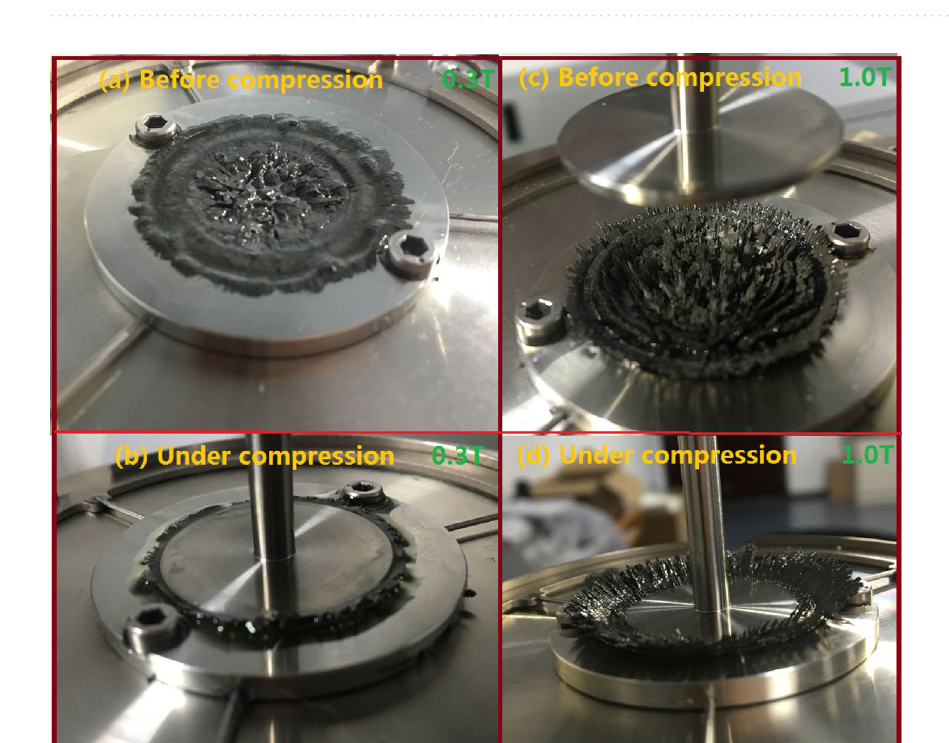
Figure 3. ( a ) The instantaneous magnetic flux density versus the gap; ( b ) The magnetic flux density changed with the applied current.